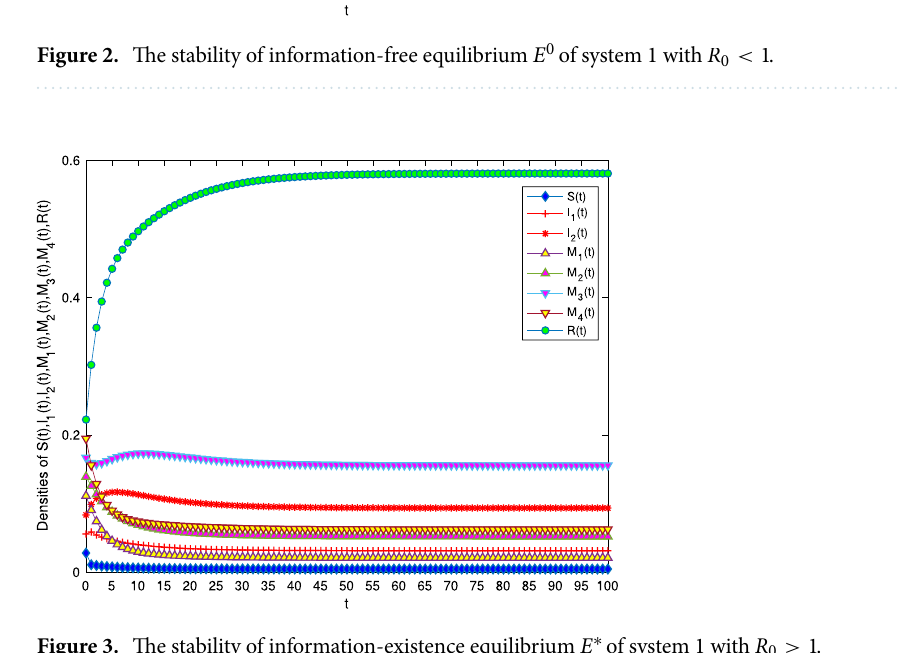
Figure 3. The stability of information-existence equilibrium E ∗ of system 1 with R 0 > 1